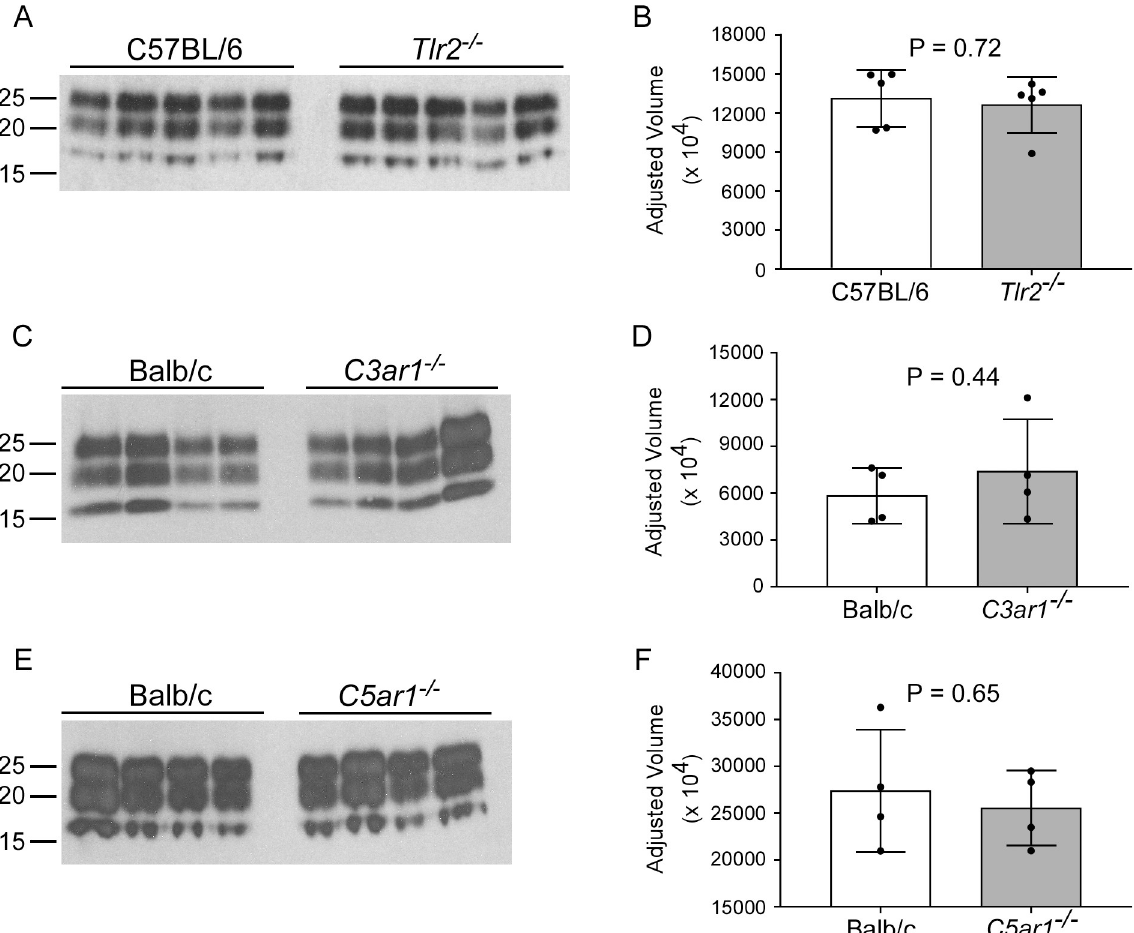
Fig 4. Western blot and densitometry of PrPres in the brains of knockout mice and control mice infected with 22L scrapie. Tlr2 -/- (A and B), C3ar1 -/- (C and D), and C5ar1 -/- (E and F) mice with appropriate control mice were infected with scrapie strain 22L and euthanized at clinical end-point. Brain homogenates were prepared and digested with proteinase K, proteins separated by SDS-PAGE, and transferred to PVDF membranes. Blocked membranes were probed with anti-PrP (D13) and bands were visualized by chemiluminescence. Panels A, C, and E were 2-minute exposures to film using ECL Western Blotting substrate. Densitometry on each lane was performed to assess differences between the groups, and plots of the adjusted volumes (see Methods) are shown to the right of the corresponding immunoblots (panels B, D, and F). Statistical analysis was performed using a two-tailed t-test comparing knockout mice to control mice. P values are as indicated.